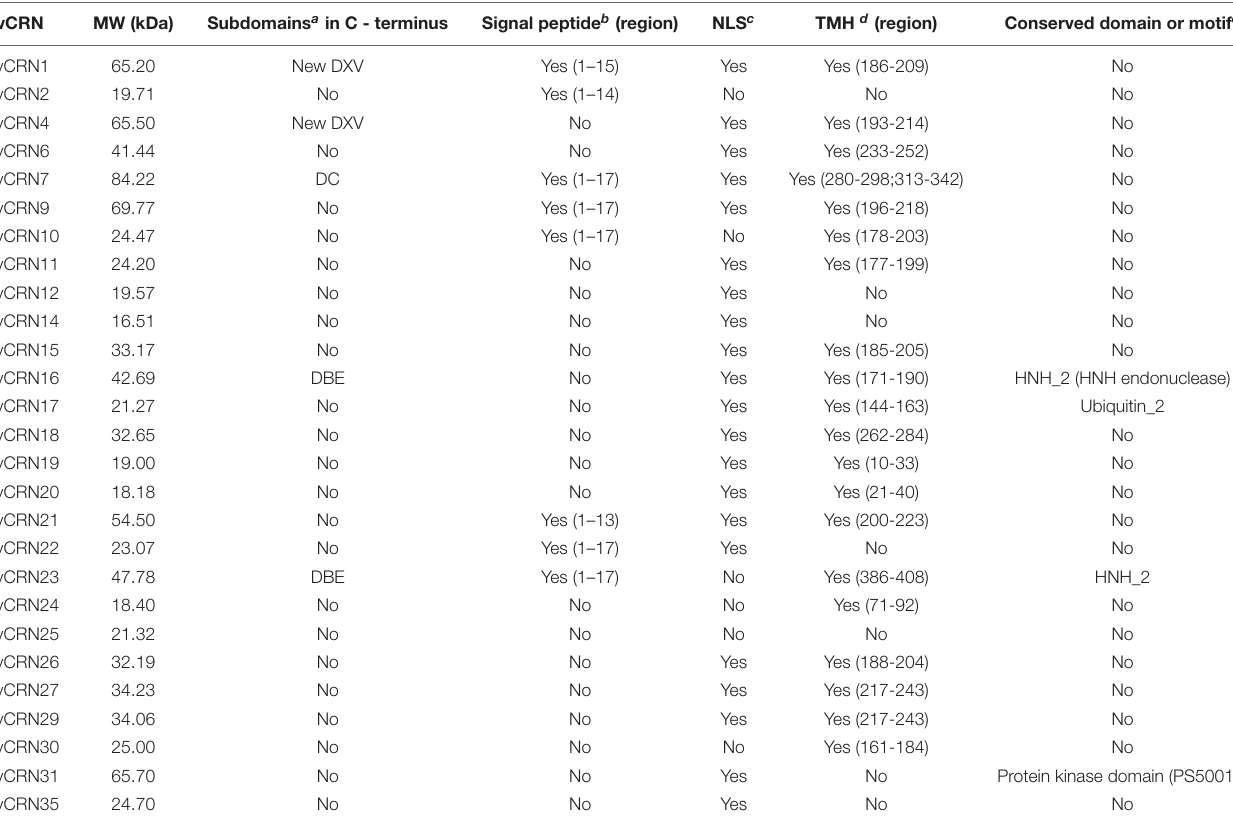
TABLE 2 | Characteristics and predicted features of PvCRN effectors in P. viticola isolate YL. PvCRN MW (kDa) Subdomains a in C - terminus Signal peptide b (region) NLS c TMH d (region) Conserved domain or motif e